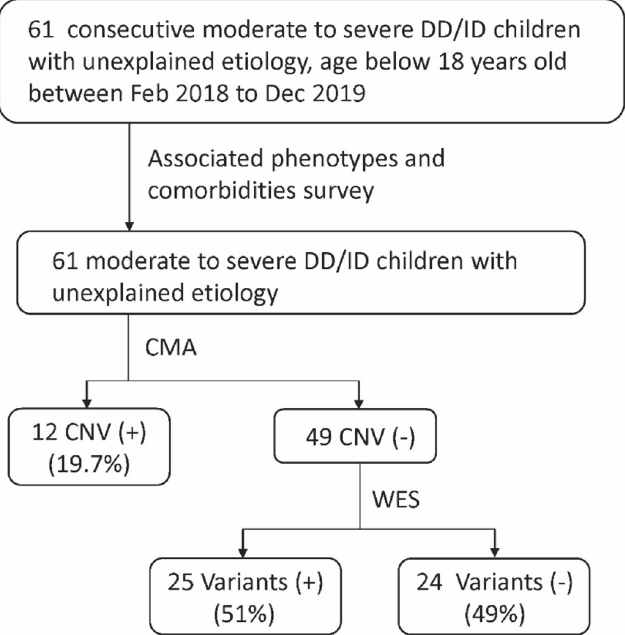
Figure 1. Flowchart of genetic survey. The developmental delay (DD)/intellectual disability (ID) children with unexplained etiology were tested with chromosomal microarray (CMA) and sequential whole-exome sequencing (WES). CNV copy-number